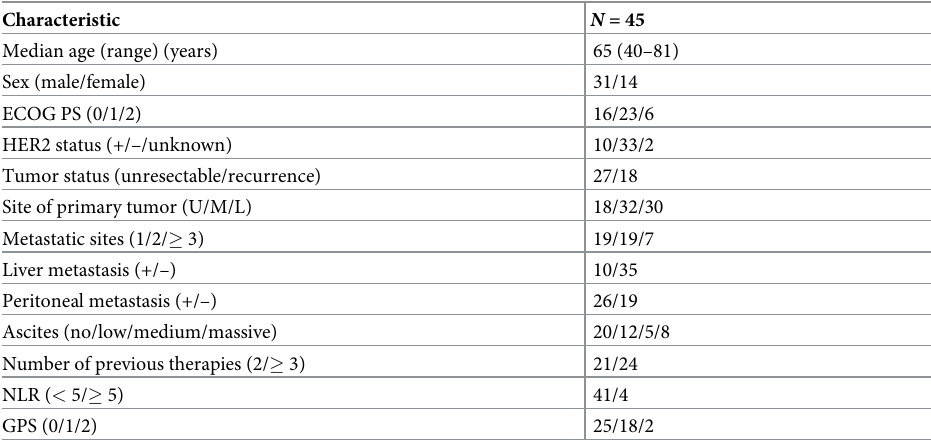
ECOG PS, Eastern Cooperative Oncology Group performance status; HER2, Human Epidermal Growth Factor Receptor 2; U/M/L, upper (U), middle (M), and lower (L) sections of the stomach; low ascites, localized buildup of ascites in the perihepatic or pelvic space; medium ascites, ascites of intermediate size; massive ascites, accumulation of ascites extending throughout the abdominal cavity; NLR, neutrophil-to-lymphocyte ratio; GPS, Glasgow prognostic